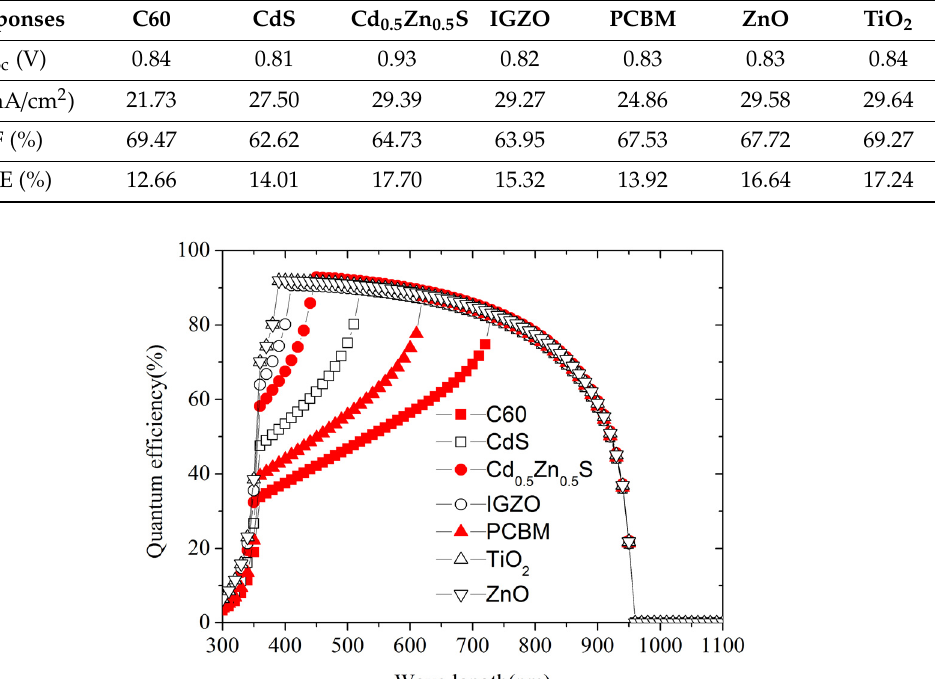
Figure 4. Band alignment between ETL materials and MASnI 3 perovskite.